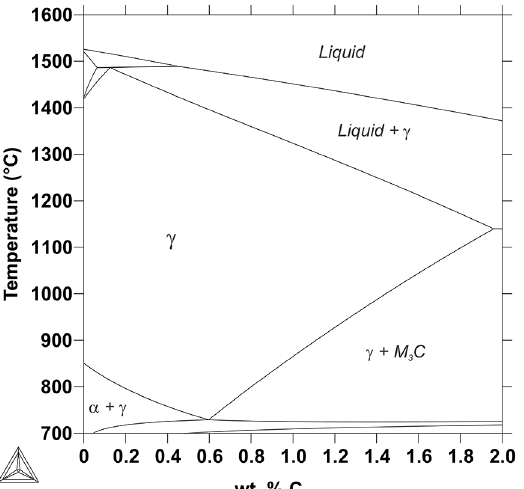
Figure 4. Isopleth for alloy composition from Table 1 without boron.